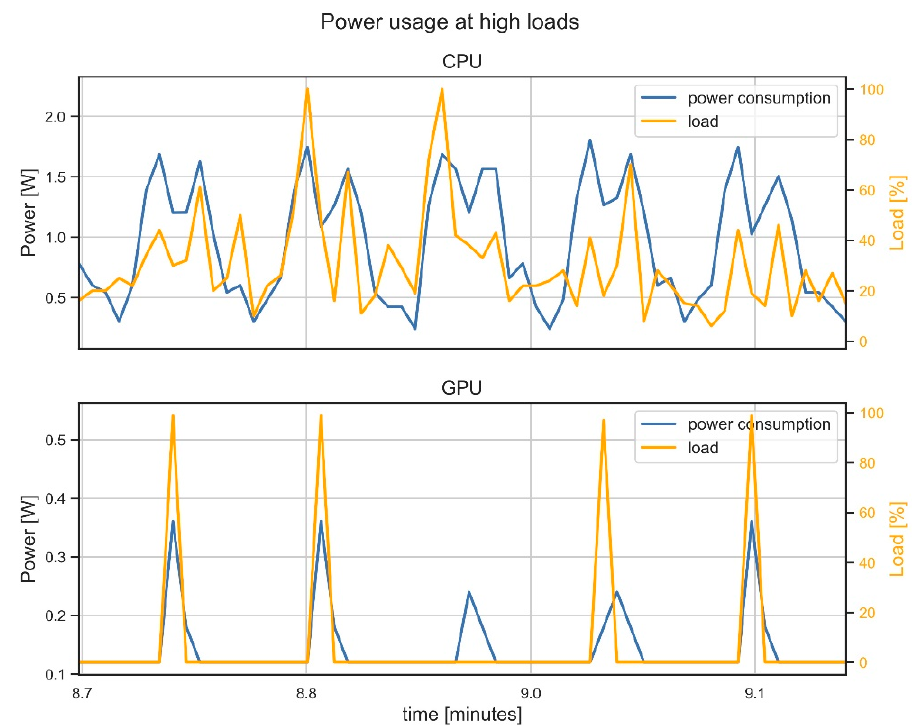
Figure 7. Power usage of the on-board unit at high computational CPU and GPU loads.